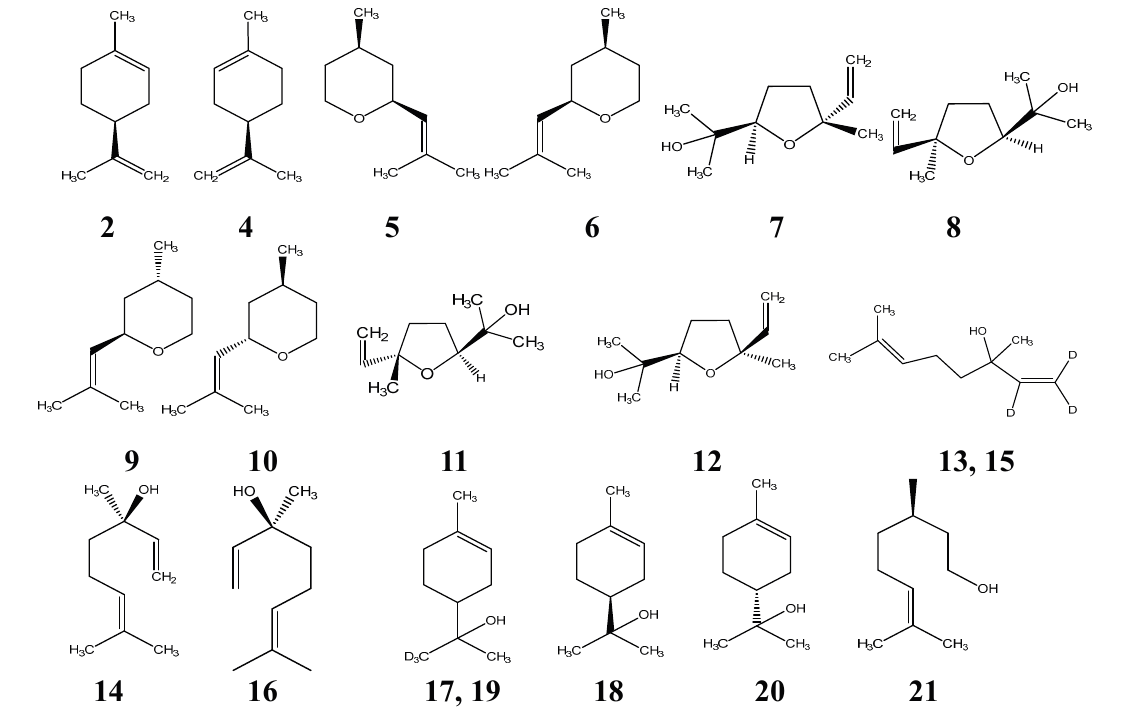
Figure 3. Chemical structures of the chiral monoterpene